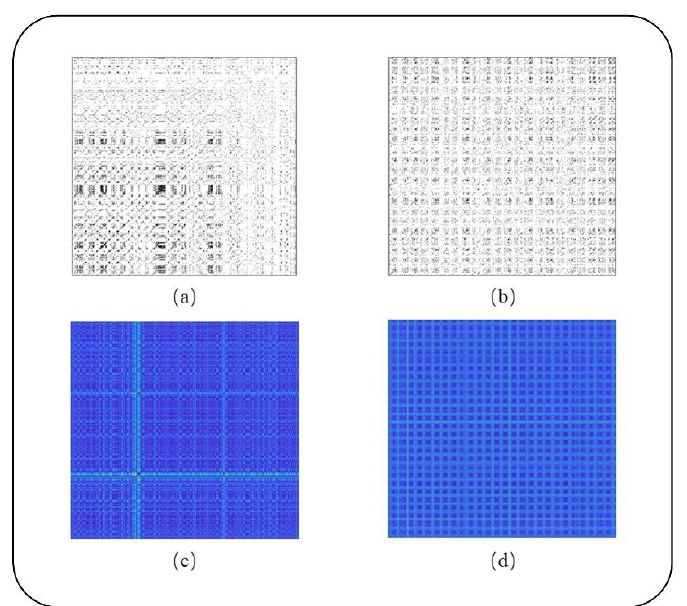
Figure 3. TRP and UTRP of AF and NAF. ( a ) is the TRP of AF, and ( b ) is the TRP of NAF; ( c ) is the UTRP of AF, and ( d ) is the UTRP of NAF. UTRP of AF, and ( d ) is the UTRP of